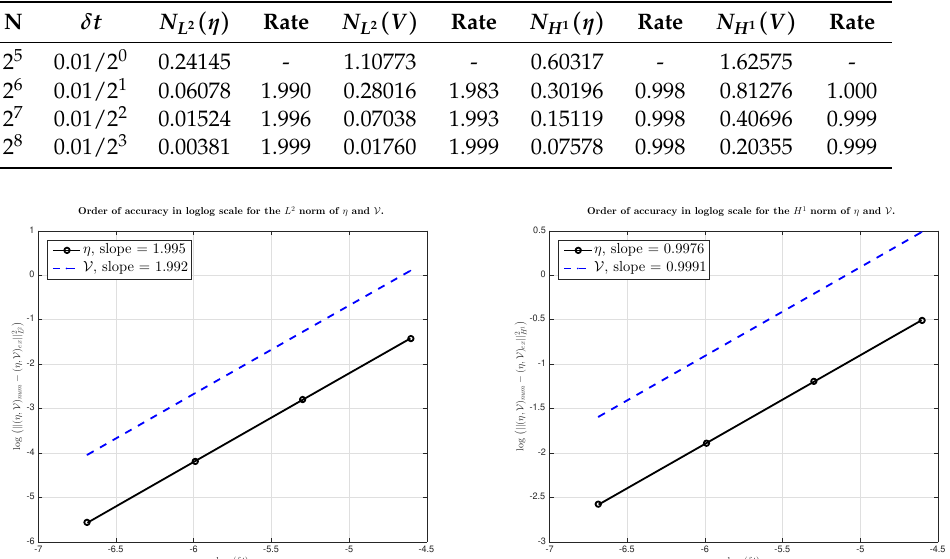
Table 1. L 2 norm of the error for η and V .